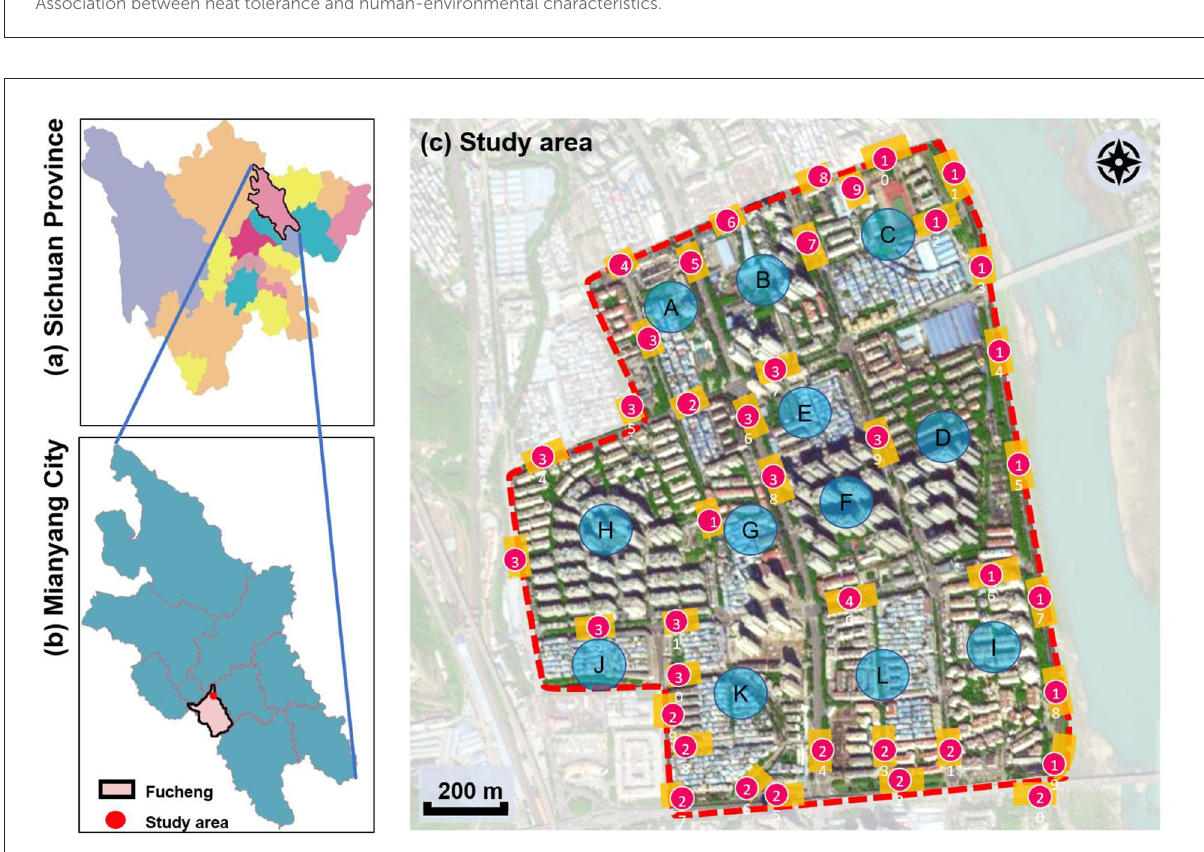
FIGURE4 Location of study area and its streets and neighborhoods. (a) Sichuan province, (b) Mianyang city, and (c) Study